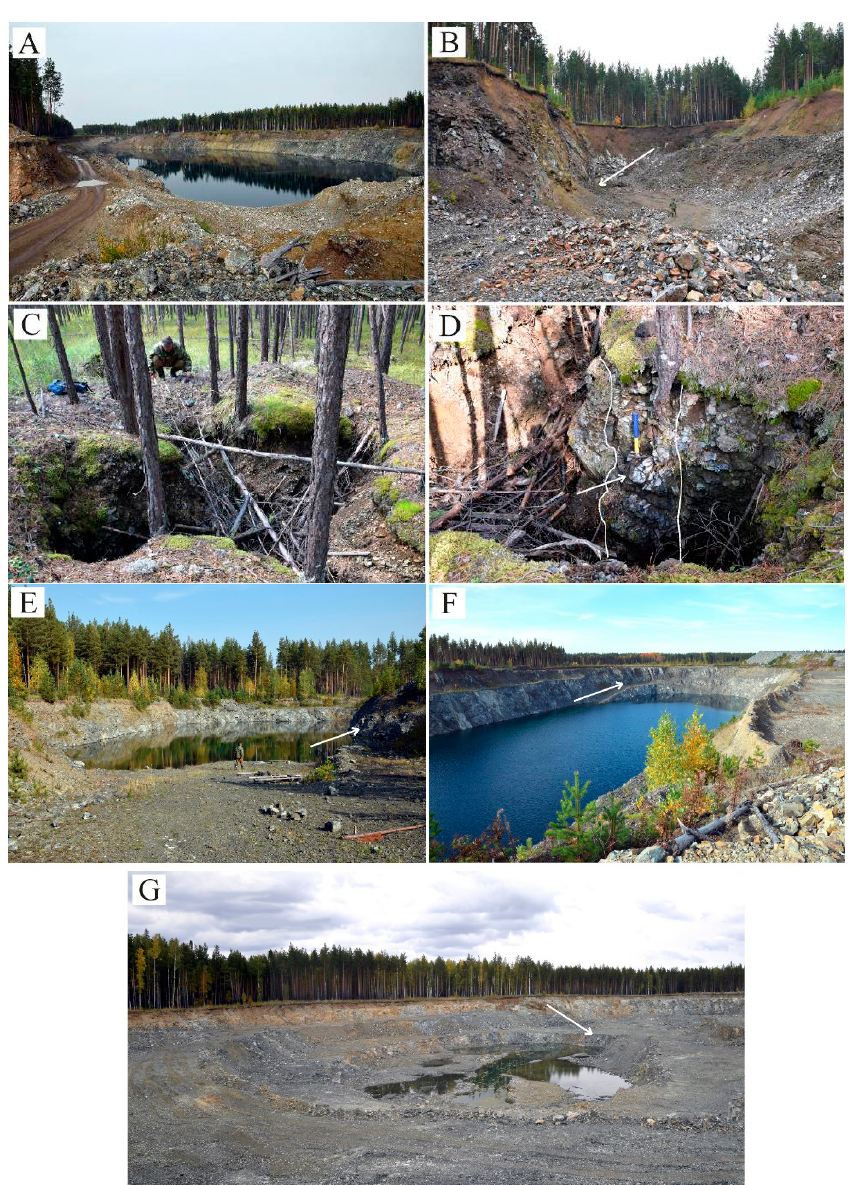
Figure 3. Overview of the chromite deposits of the Alapaevsk massif, Central Urals. Kurmanovskoe chromite deposit: ( A ) general view of open pit and ( B ) the location of the studied sample; Krest chromite deposit: ( C ) the exploration trench and ( D ) vertical ore body of massif chromite in dunite; ( E ) open pit of the Bol’shaya Kruglyshka chromite deposit; ( F ) open pit of the 3-d Podyony Rudnik chromite deposit; ( G ) open pit of the Lesnoe chromite deposit. Arrows indicate sample locations.